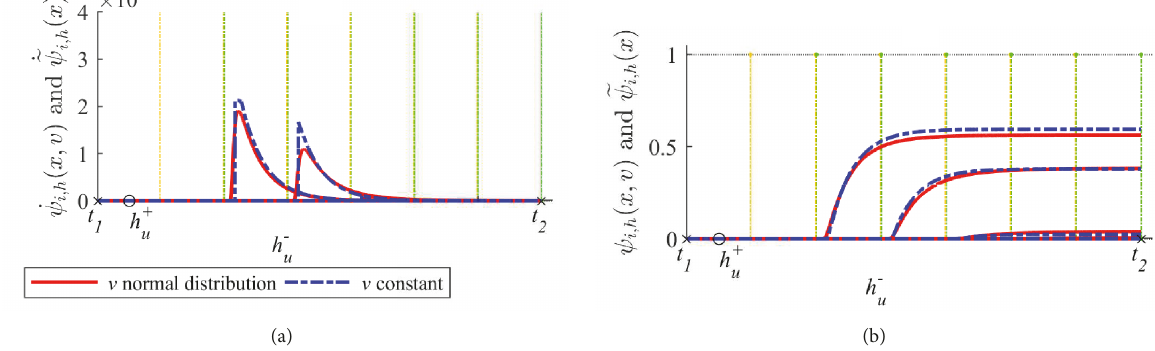
Figure 2: With respect to tap-out instant: (a) bricks of PDFs and (b) bricks of